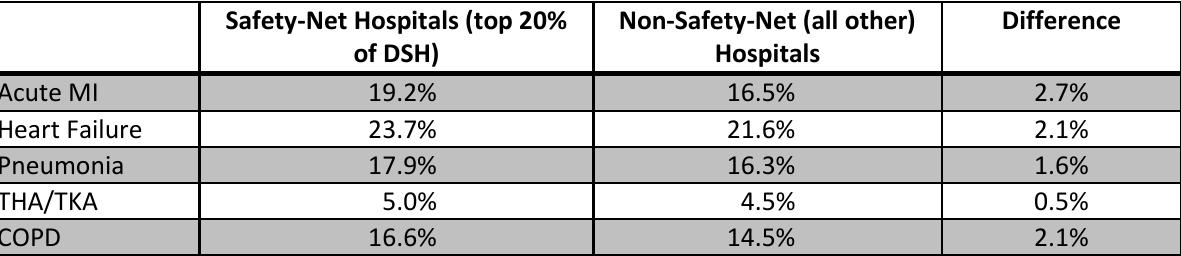
Table 5.4. Risk-Standardized Readmission Rates by Safety-Net